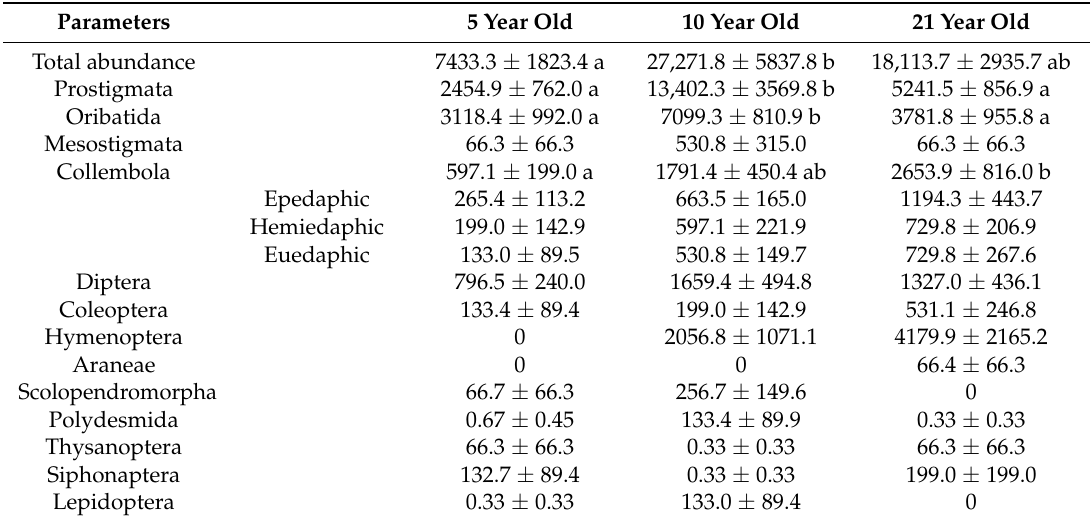
Table 1. The abundance (ind m − 2 ) of soil arthropod groups in the three stand ages.